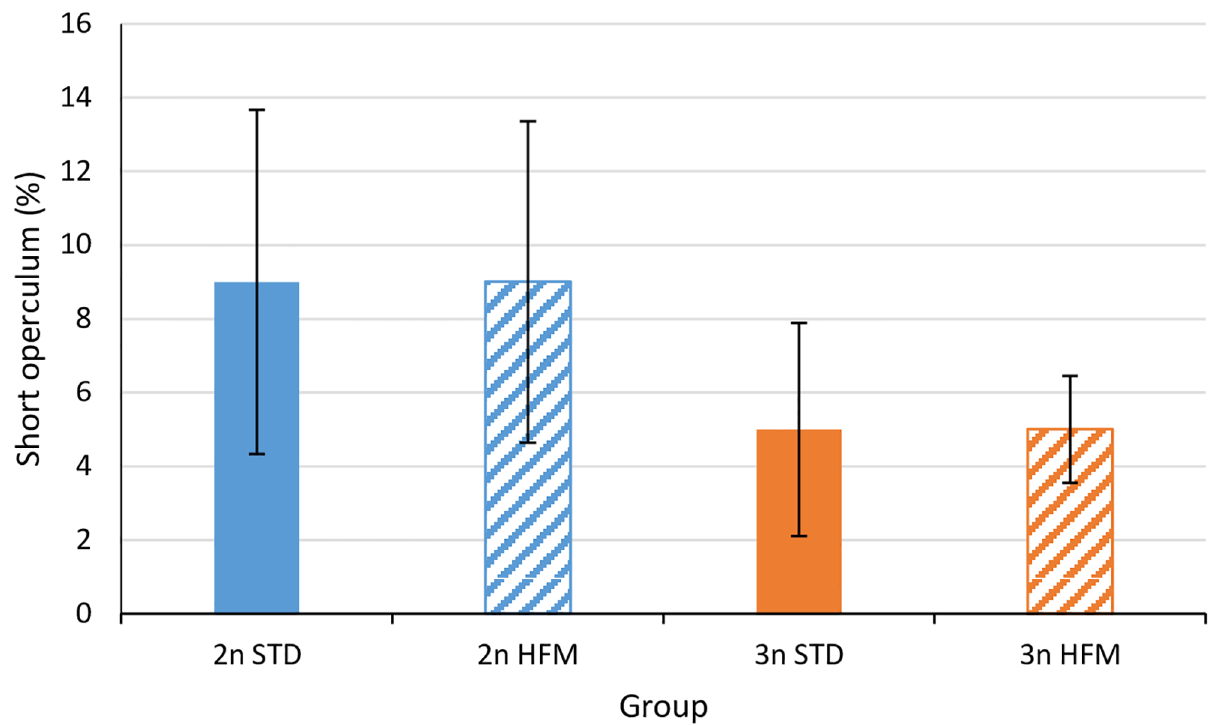
Fig 5. Percentage of short opercula in salmon parr. Percentages of short opercula in diploid (2n) and triploid (3n) Atlantic salmon, Salmo salar , parr (1390 ddPSF) fed fish meal (STD) and hydrolyzed fish protein (HFM) diets. Data are presented as mean ± SEM (n = 3).